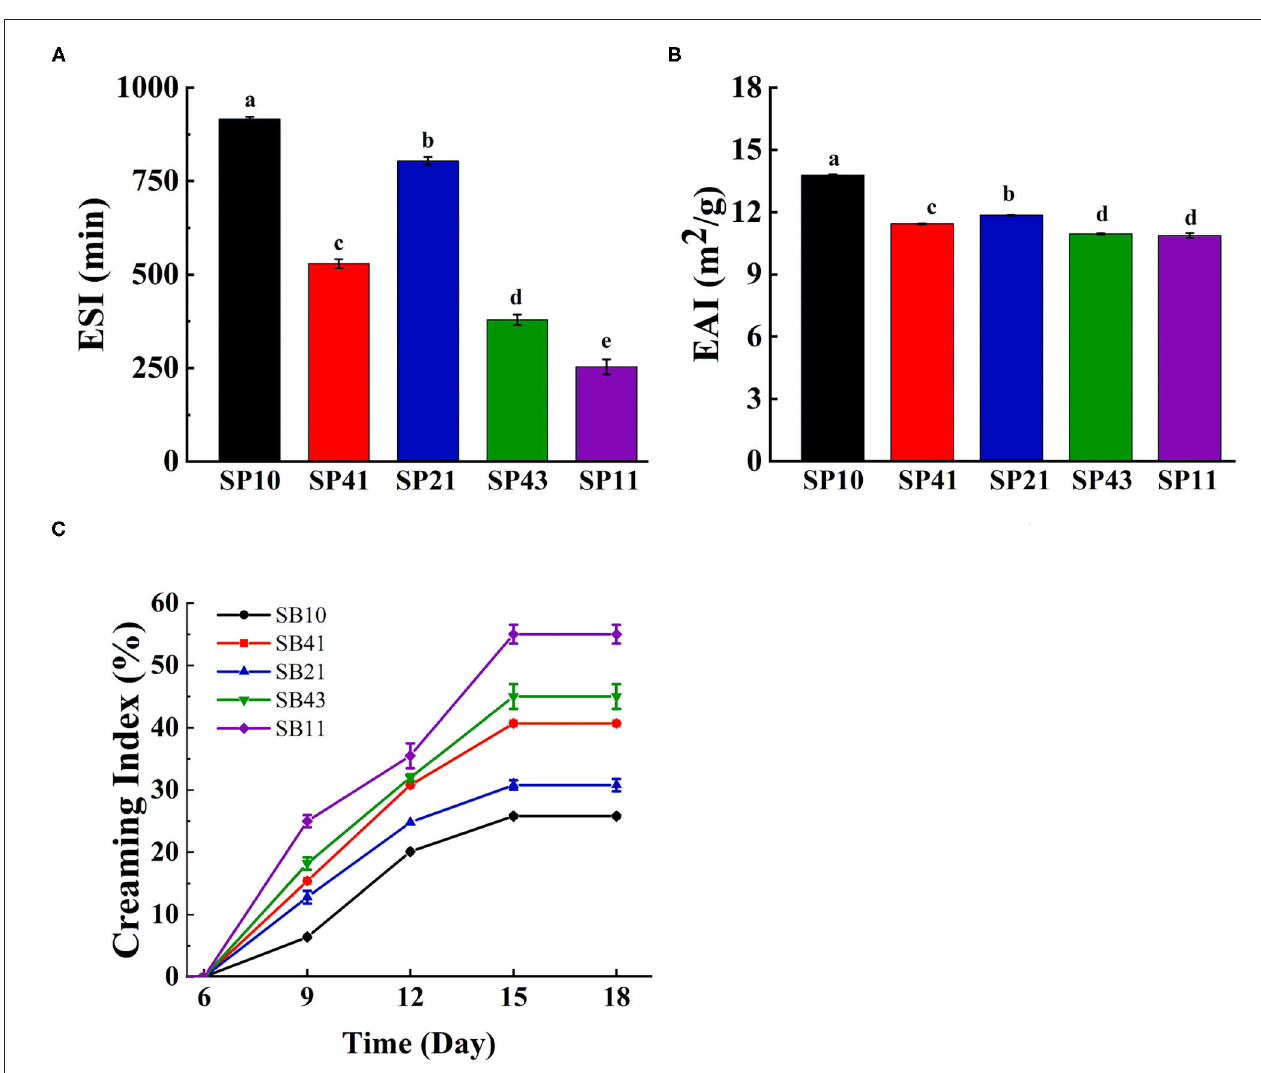
FIGURE 5 | Emulsifying stability index (ESI) (A) , emulsion activity index (EAI) (B) , creaming index (CI) (C) of SPI, BPC and different SPI/BPC ratios (4:1, 2:1, 4:3, 1:1).